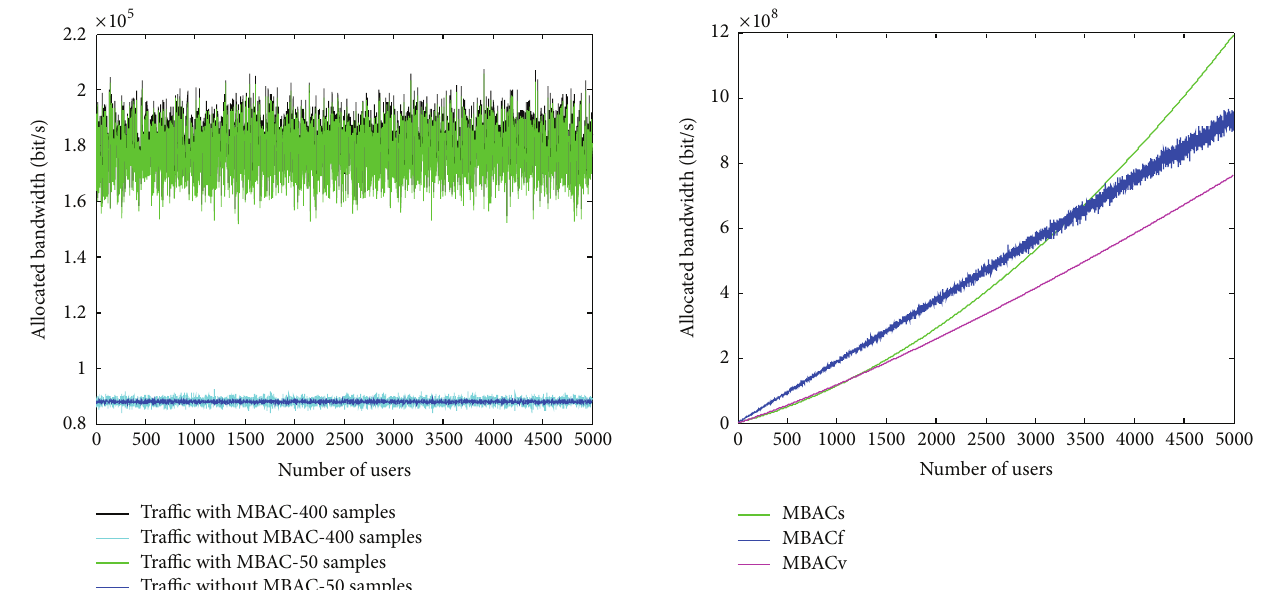
Figure 7: Allocating of bandwidth based on the number of samples.